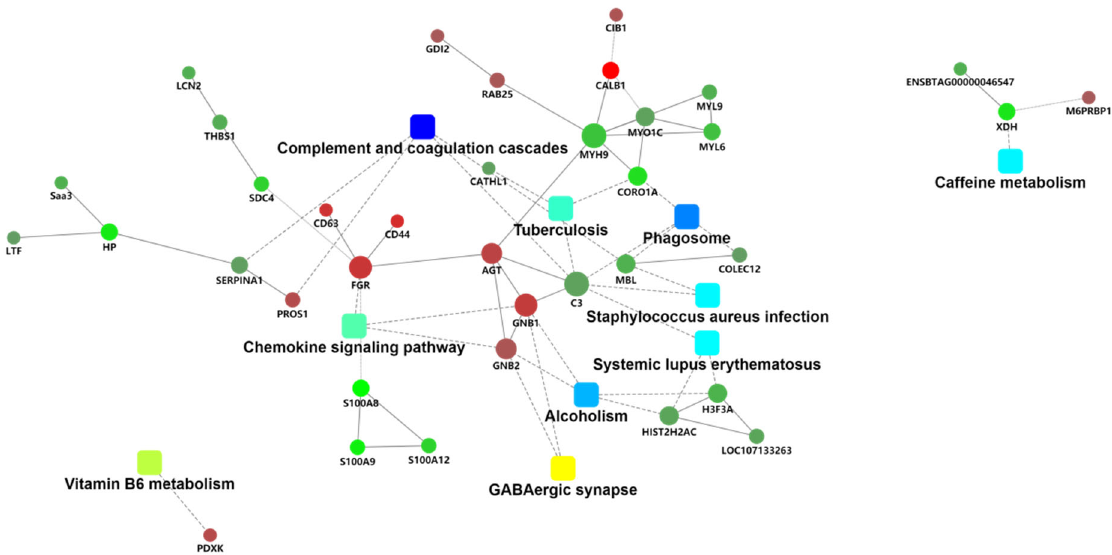
Figure 4. The protein–protein interaction of differentially expressed proteins by Omics Bean. Dots represented proteins: red for up-regulated proteins and green for down-regulated proteins. Rounded rectangles represented molecular functions, cellular components, biological processes, and signaling pathways, with blue meaning higher significance and yellow meaning lower significance. Rectangle referred to KEGG pathway or biological process, which were colored with gradient color from yellow (smaller p ‐ value) to blue (bigger p ‐ value).